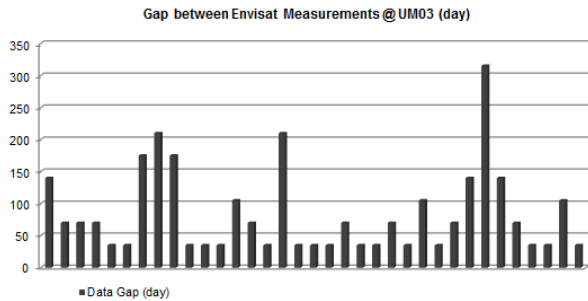
Figure 9. Gaps between Envisat observations of water levels over site